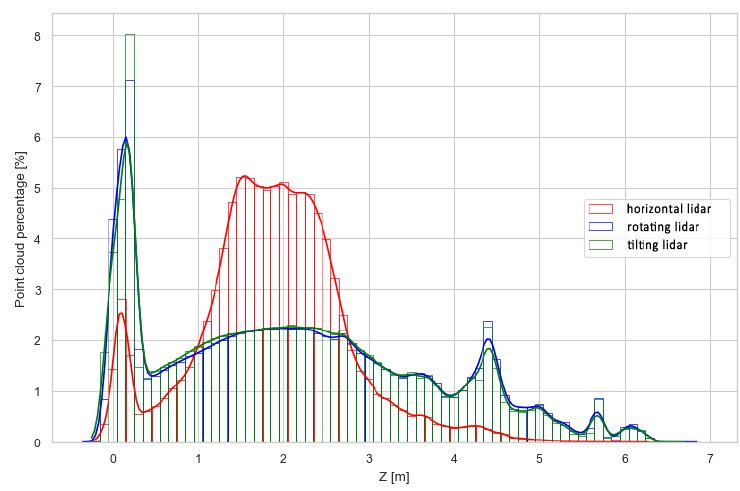
Figure 14. Distribution of points along the z -axis—relative values.